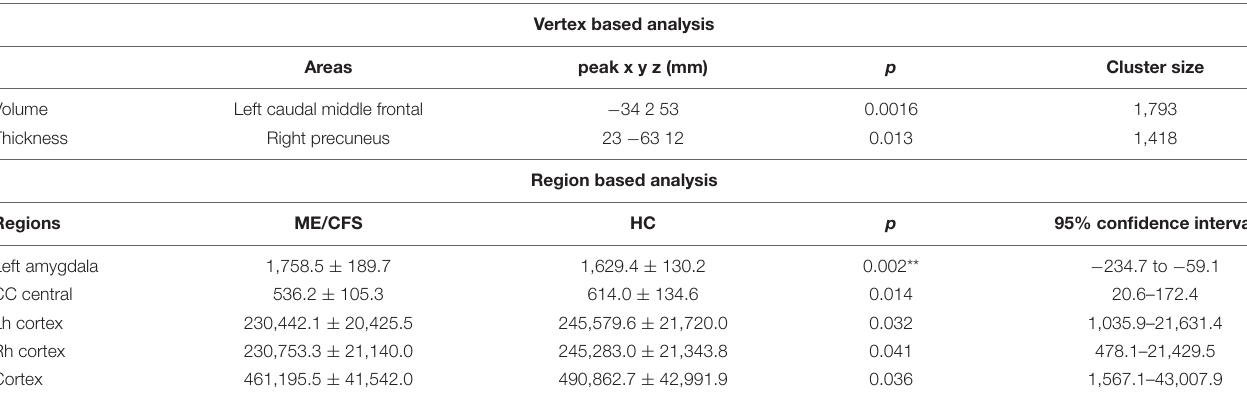
TABLE 2 | Vertex and region-based analysis of cortical regions in ME/CFS patients compared to HC. Vertex based analysis Areas peak x y z